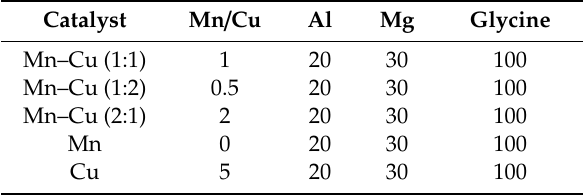
Table 1. Stoichiometric ratio and nomenclature of oxide-mixed catalyst.